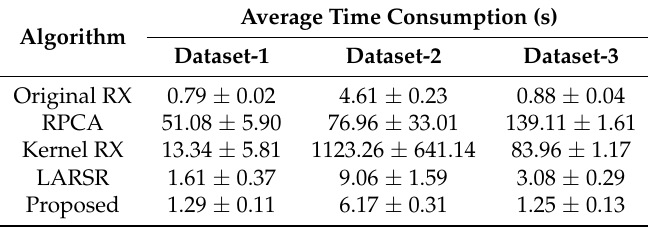
Table 9. Time consumption performances (For Dataset-1 and Dataset-2, we calculate the average and standard deviation of each